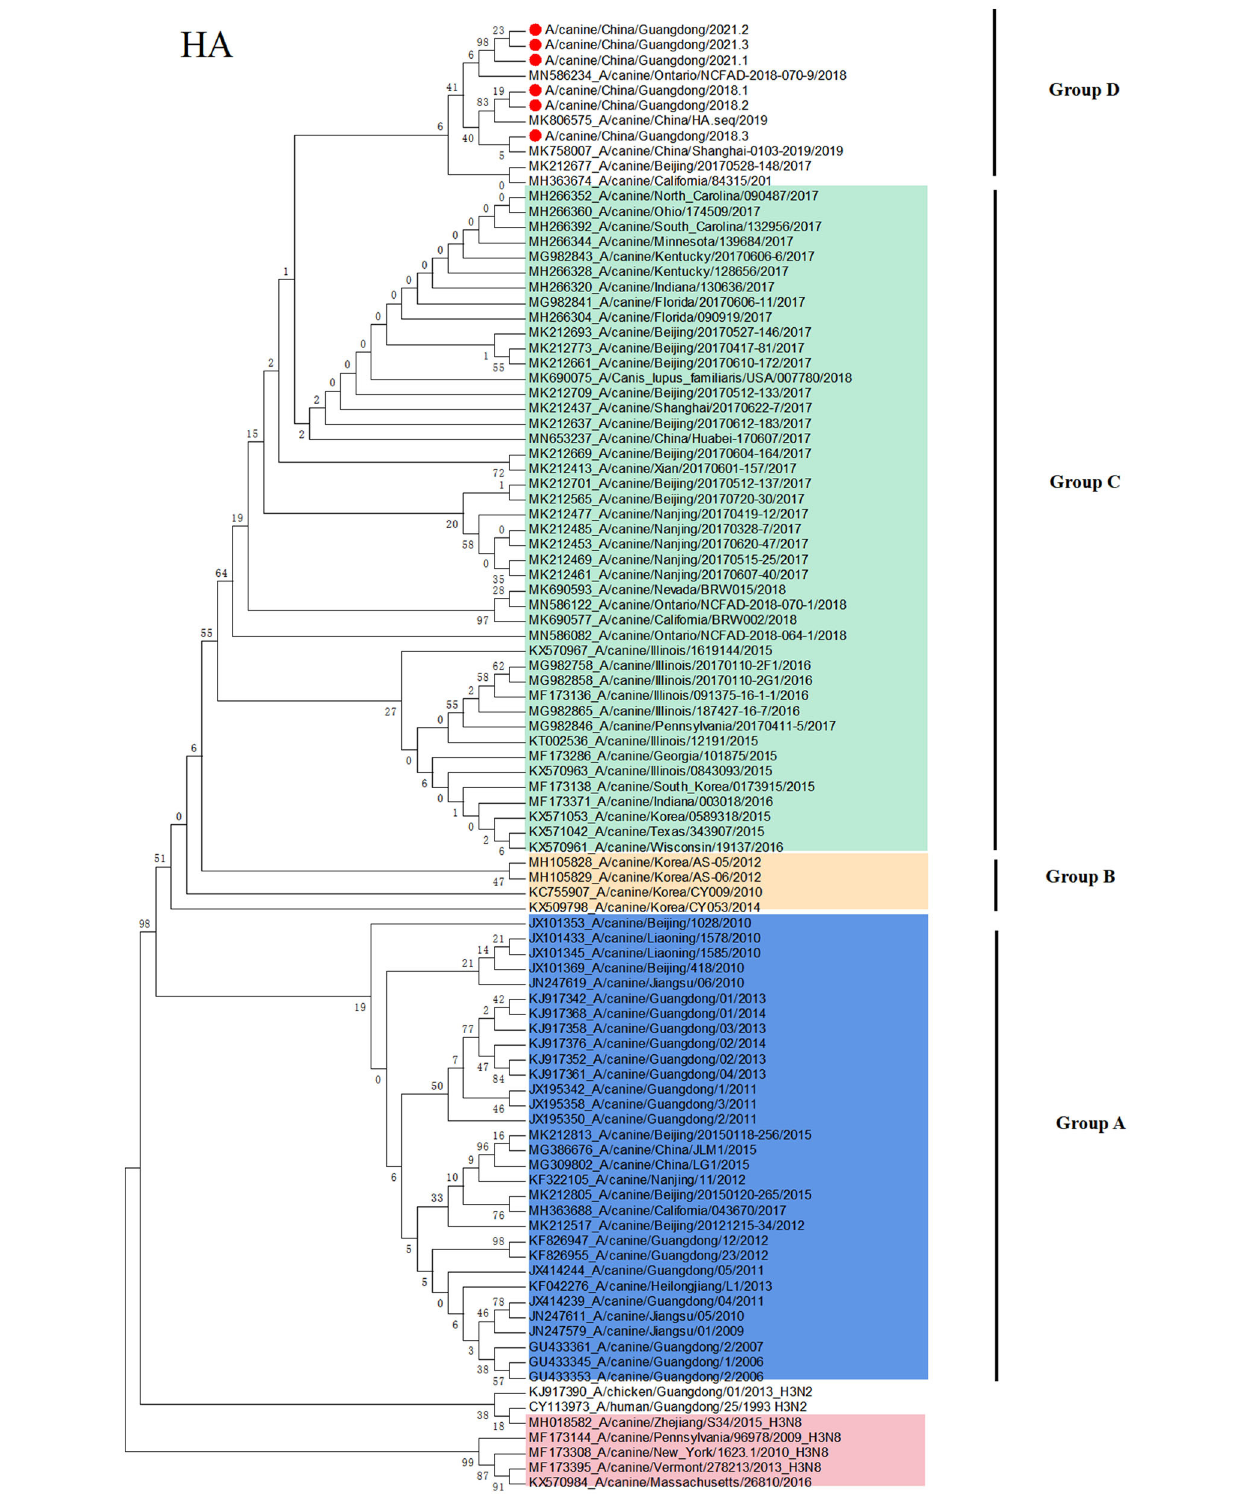
FIGURE 1 | Phylogenetic analysis of H3N2 CIV based on the HA protein. Colors indicate H3N8 CIV (red) and isolates from different geographical regions of H3N2 CIV originating from the United States (green), Korea (yellow), and China (blue). The six Chinese strains sequenced in this study are indicated by red circles.